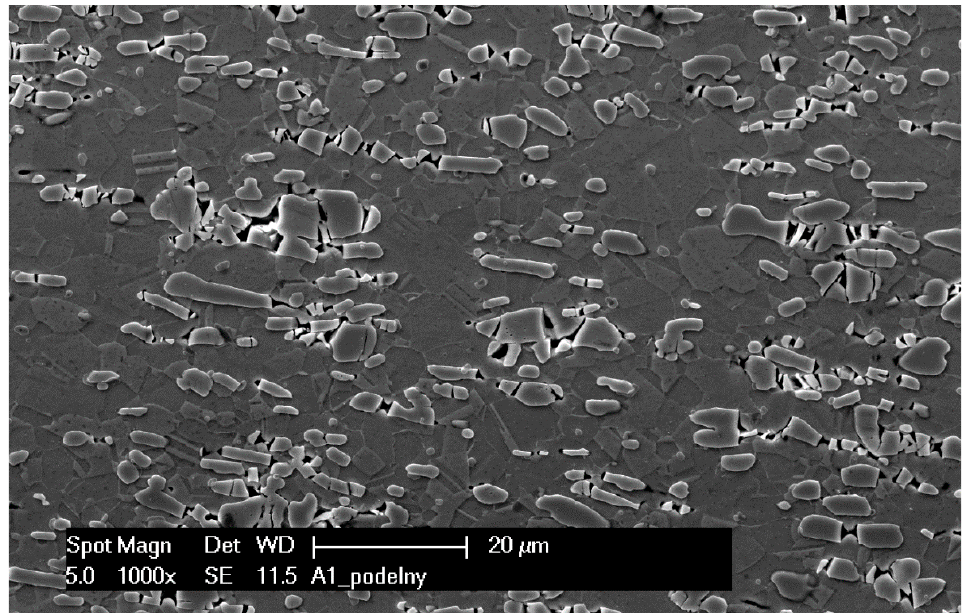
Figure 15. Brittle fracture of borides and cavities generation.